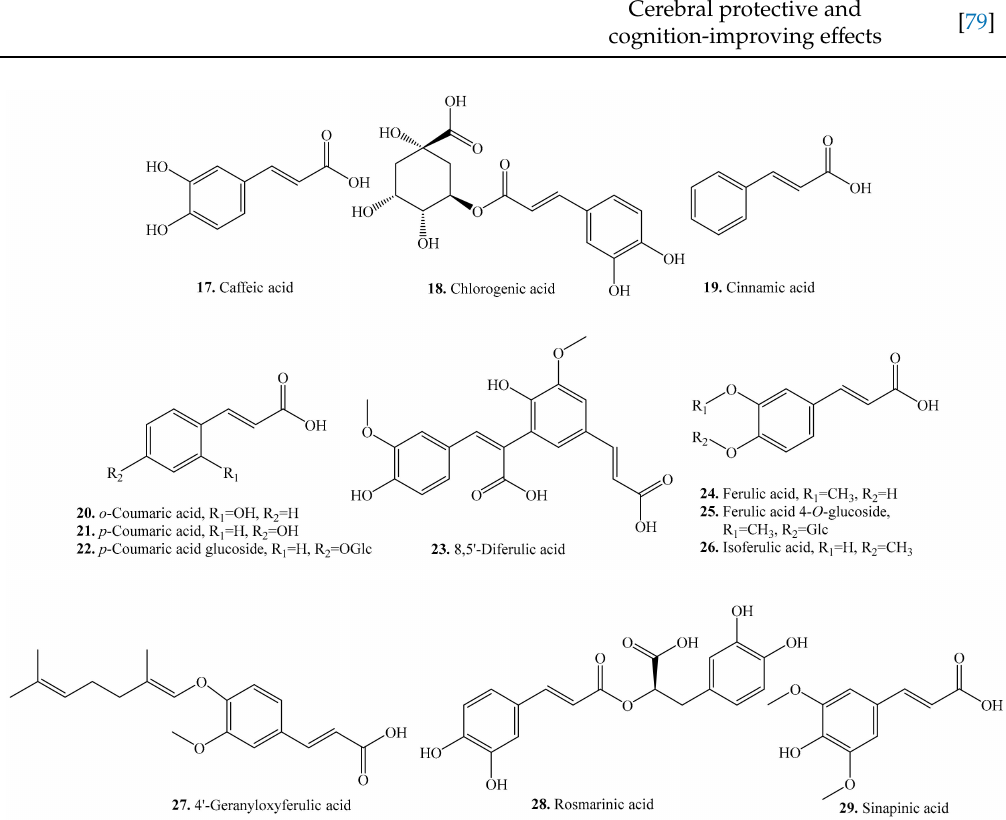
Figure 2. Structures of the cinnamic acid analogues isolated from